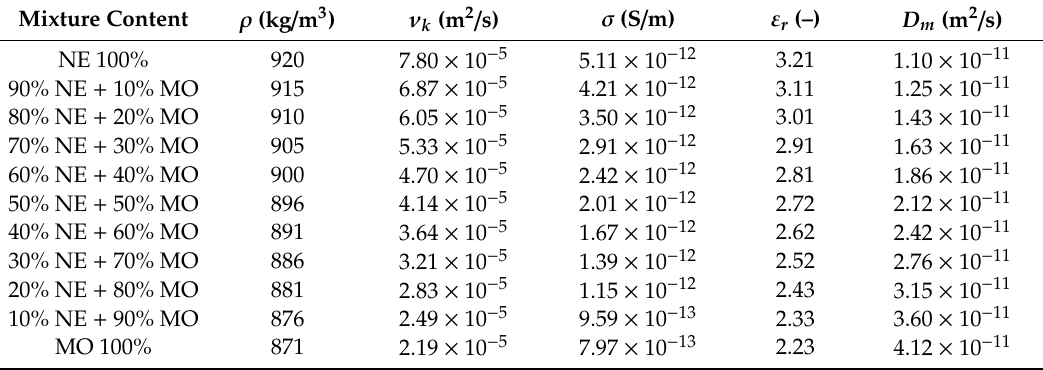
Table 1. Properties of Envirotemp FR3 natural ester and fresh Trafo EN mineral oil mixtures (20 ◦ C).